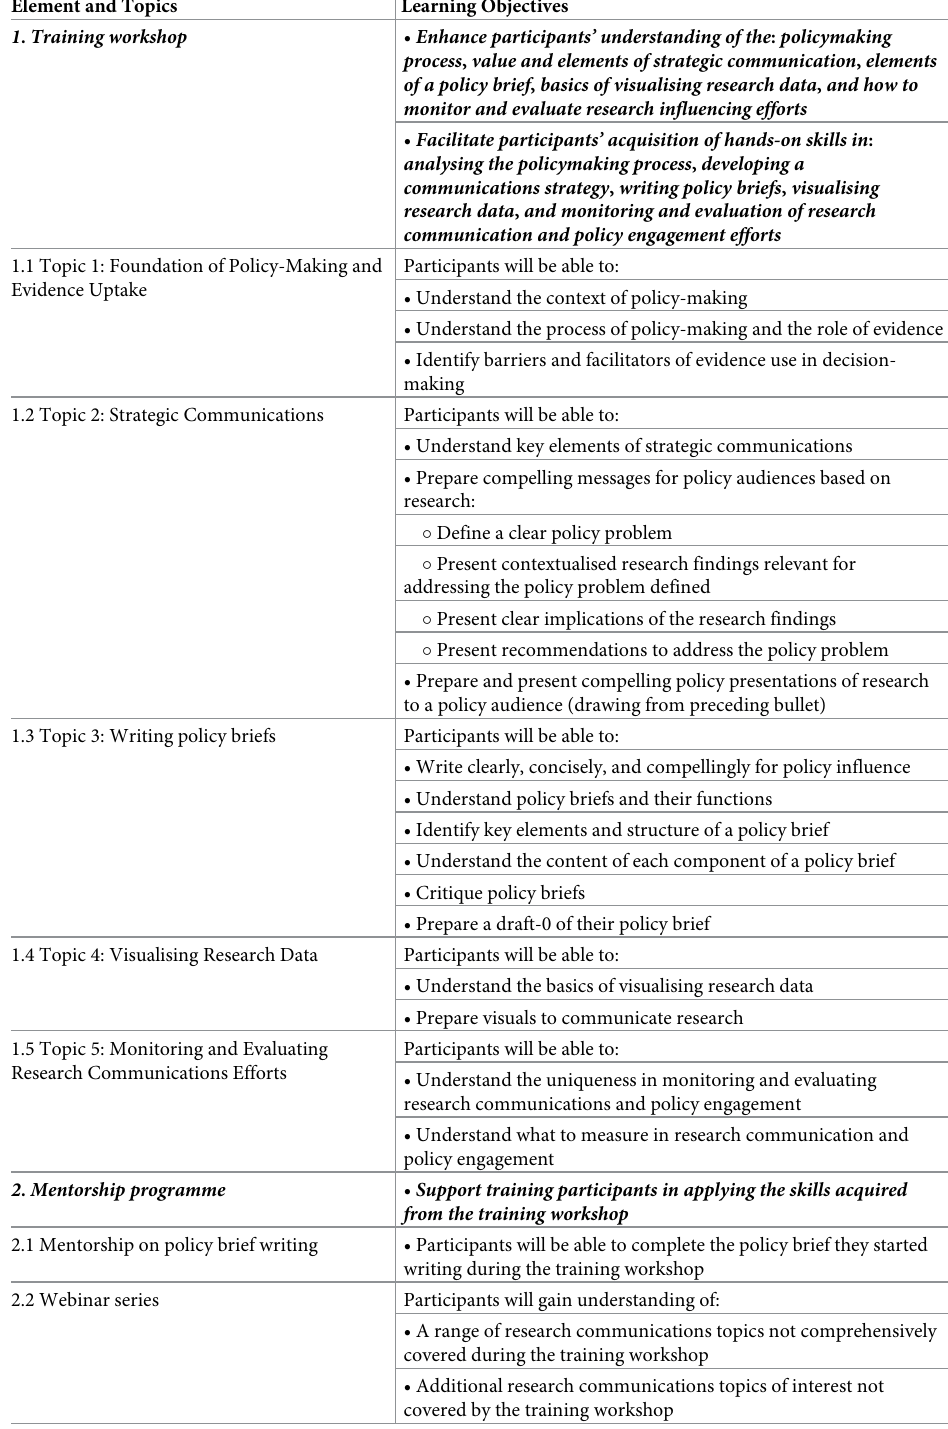
Table 2. Learning objectives of the KT training